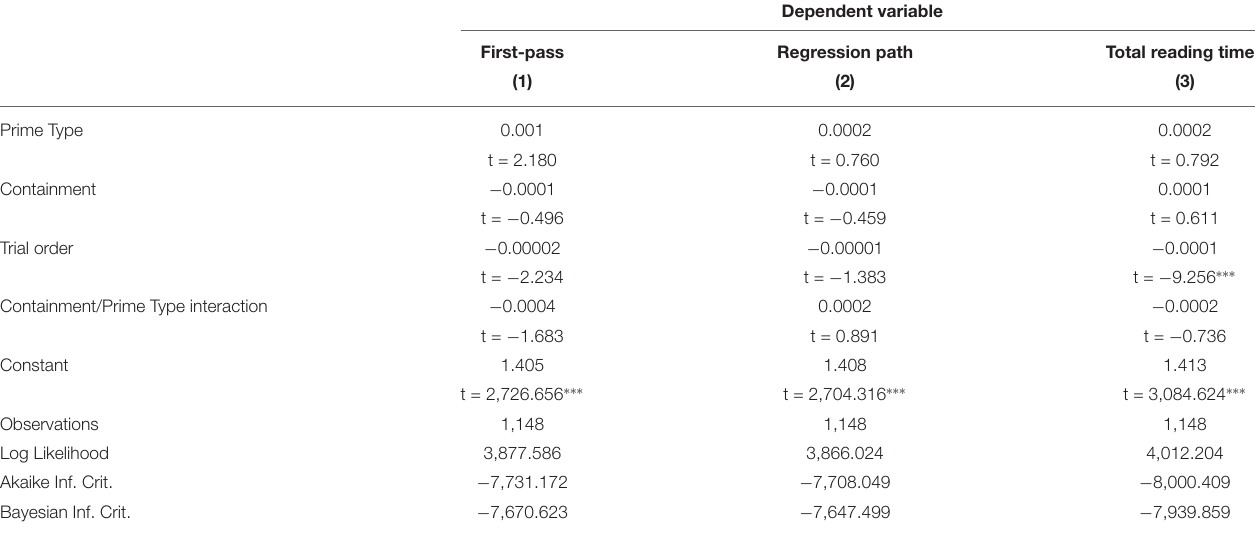
TABLE 5 | Regression analysis of reading times in the VERB region of Experiment 1.